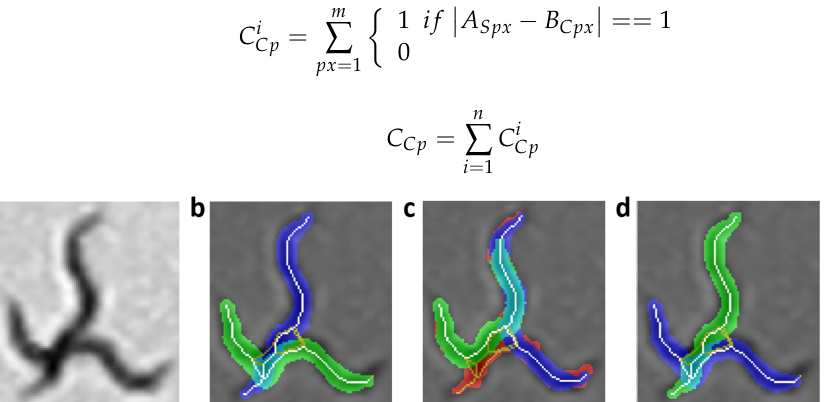
Figure 6. Completeness criterion evaluation. The pixels in red are the completeness error. The yellow and white pixels are the resulting skeleton using the improved form of skeletonizing. The white pixels are the pixels of the skeleton prediction, which are used to reconstruct the body of each worm (segmentation in blue and green). ( a ) Grayscale image. ( b ) Correct prediction with low completeness criterion. ( c ) Incorrect prediction with high completeness criterion. ( d ) Identities changed and with the same completeness criterion as image ( b